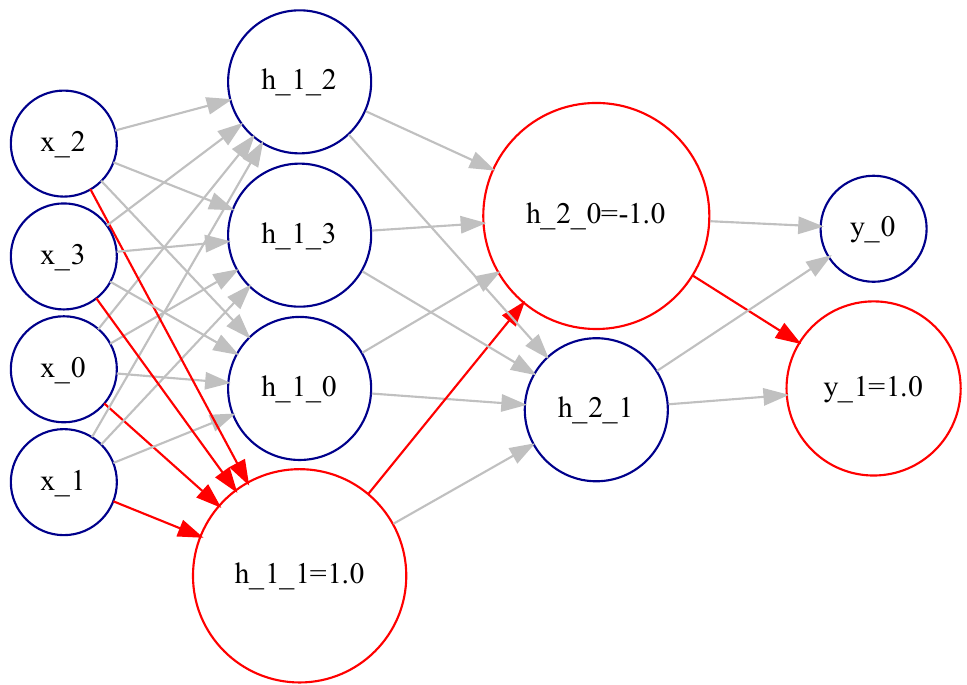
Figure 12. The activation pattern (automatically generated) for class 1 is highlighted in red over the DL predictor architecture on the Banknote dataset. In addition, the most frequent activation values are shown for neurons in the activation